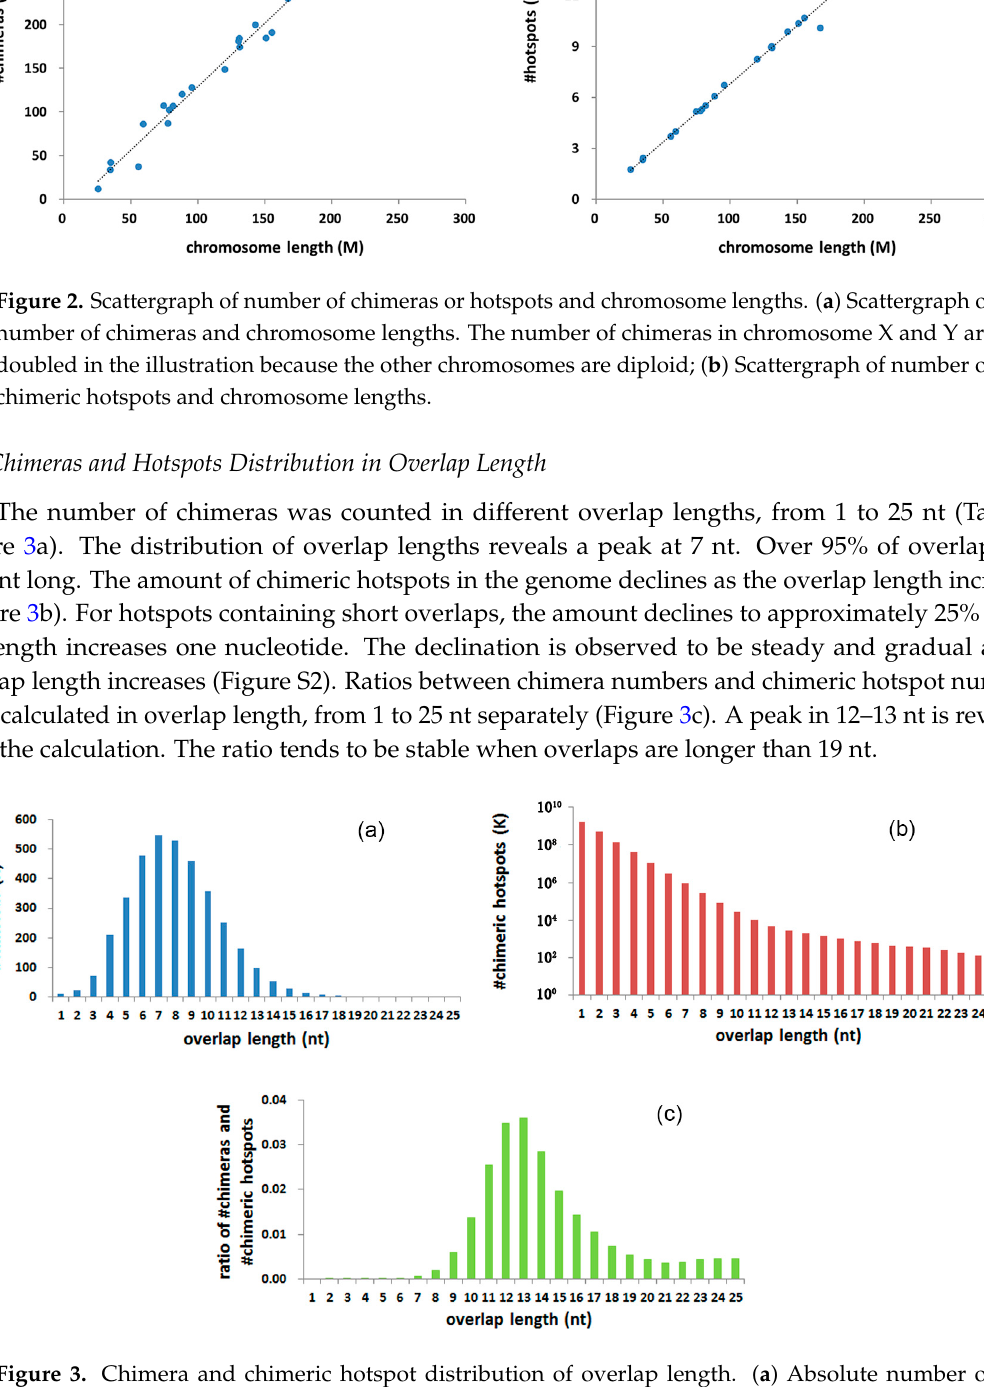
Figure 3. Chimera and chimeric hotspot distribution of overlap length. ( a ) Absolute number of chimeras with different overlap lengths; ( b ) Absolute number of chimeric hotspots with different overlap lengths. Hotspots for 1–2 nt were only screened in chromosome 10, and the numbers representing the whole genome were calculated by multiplying the size difference between chromosome 10 and the whole genome; ( c ) The ratio between the number of chimeras and hotspots with different overlap lengths.